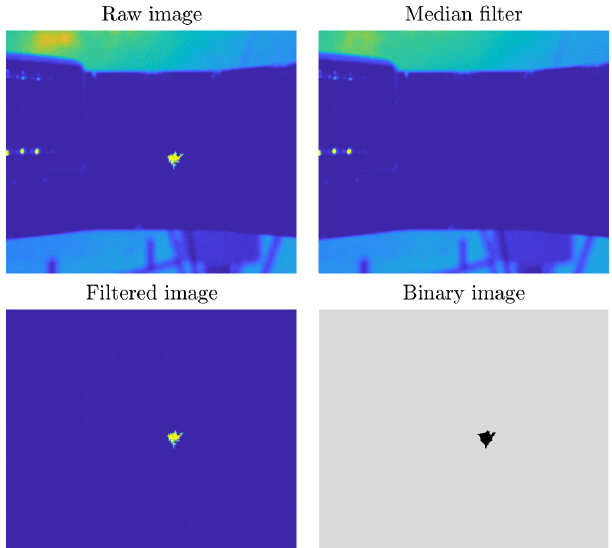
Figure 5. Raw image, median filter, filtered image and final binary image for an example of a hydrometeor. The color scheme is used to enhance details for visual